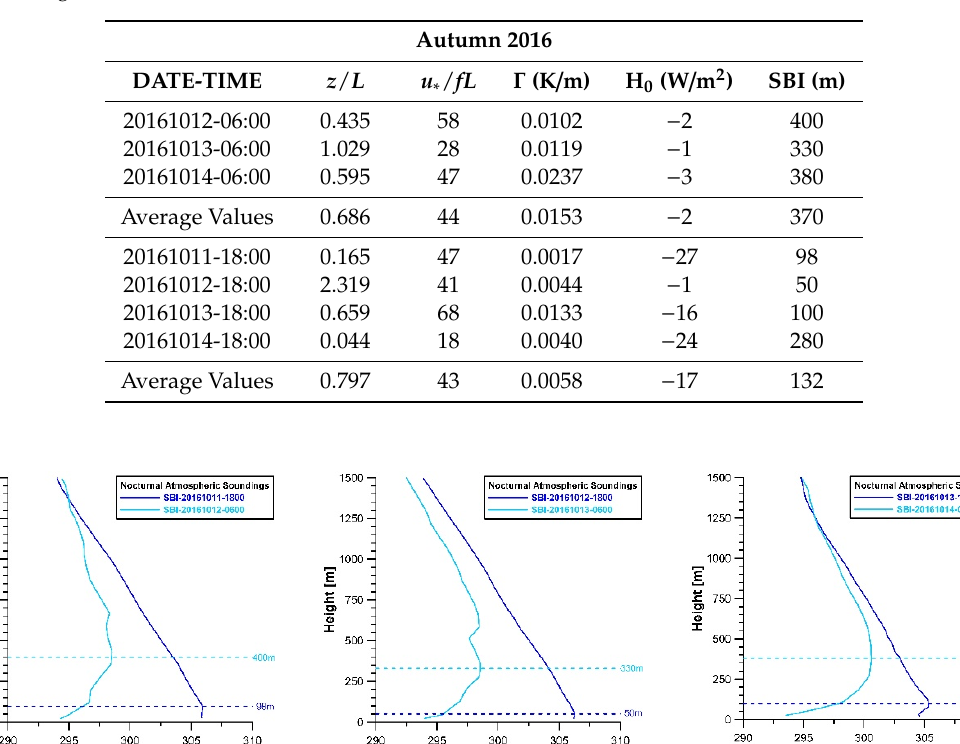
Table 9. The nocturnal stability conditions of the Mexicali Valley during the autumn 2016 campaign. The height of the SBL estimated from surface-based inversion.